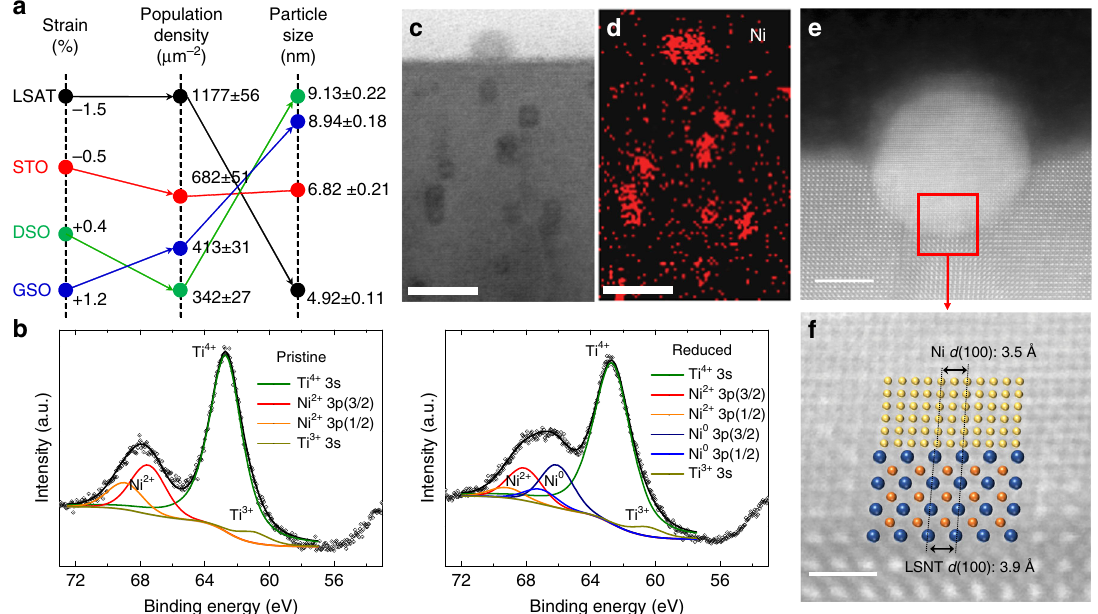
Fig. 2 Characteristics of the exsolution in thin fi lms. a Effects of the substrate on three important physical parameters related to the exsolved thin fi lms. b Ni 3 p , Ti 3 s XPS of pristine and reduced LSNT fi lms grown on LSAT substrates. c Ex-situ cross-sectional STEM-HAADF image and d corresponding Ni EDS map of the reduced fi lm on LSAT substrate. The reduction was performed at 550°C for 80 h in pure H 2 . Scale bars, 10 nm. e Cross-sectional bright- fi eld STEM image of a Ni particle exsolved on (100) perovskite surface after reducing at 900 °C for 12 h in pure H image at the metal-perovskite interface, where turquoise circles denote La or Sr ions and orange circles denote Ni or Ti ions in the perovskite lattice, and yellow circles denote Ni ions in exsolved particles. Scale bar, 1